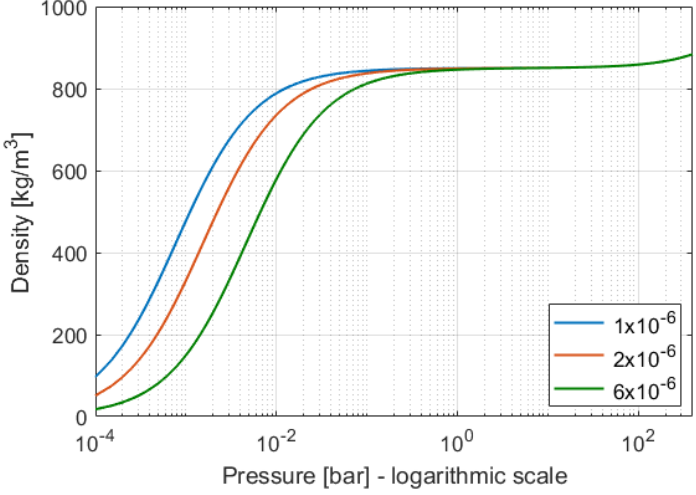
Figure 1. Fluid density versus pressure. Fluid temperature 320 K.